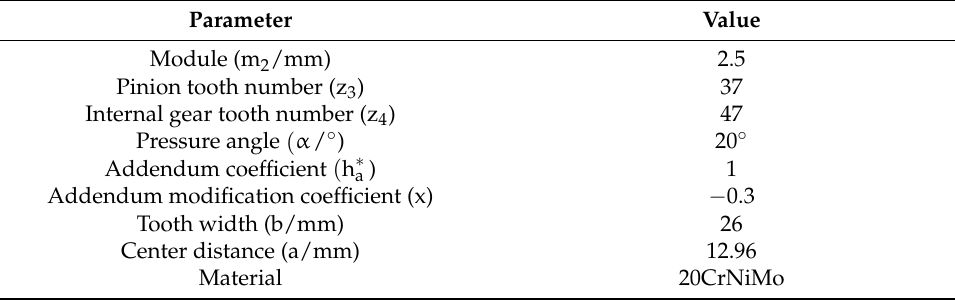
Figure 15. Test gear dive: ( a ) HCR pinion; ( b ) involute pinion. Table 3. Design parameters for involute internal spur gear